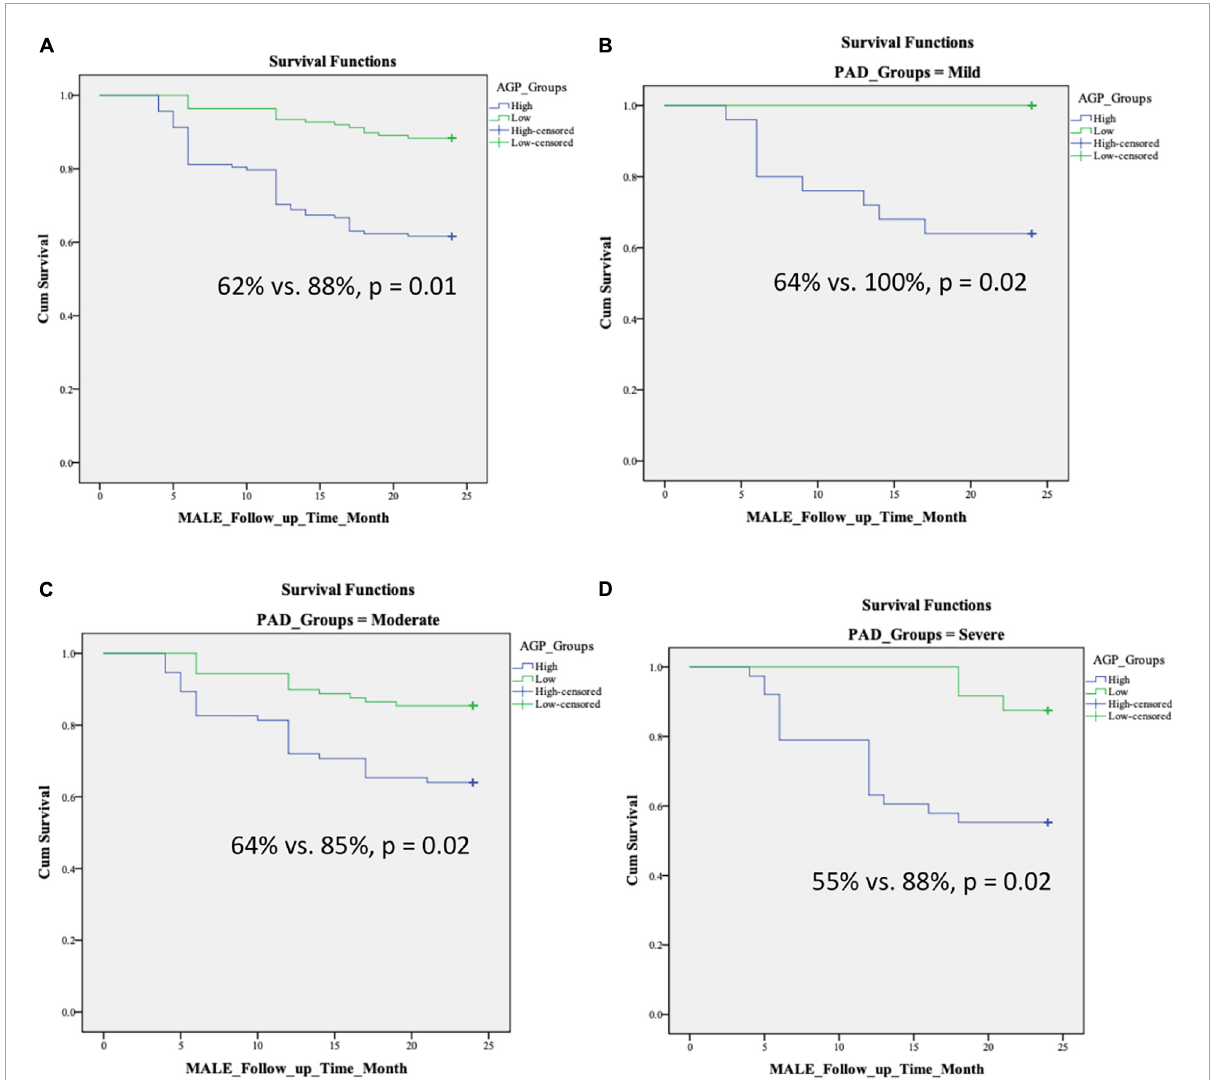
FIGURE2 Kaplan–Meier curves demonstrating MALE-free survival rates over a 2-year follow-up period in patients with low and high AGP levels based on disease severity: (A) all PAD, (B) mild PAD, (C) moderate PAD, (D) severe PAD. Stratification into low vs. high AGP groups was based on the median level in our cohort. MALE, major adverse limb event; composite of vascular intervention and major amputation; PAD, peripheral artery